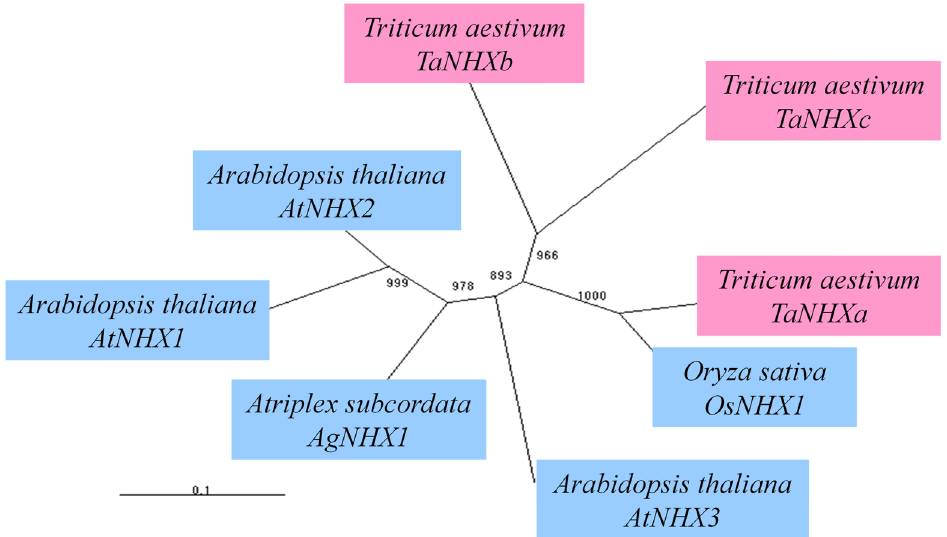
Figure 3 – Evolutionary tree of deduced amino acid sequences of wheat Na + /H + antiporter-like genes. Homogeneity was examined by creating an evolutionary tree of all amino acid sequences of the NHX genes. TaNHXa of bread wheat showed the highest homogeneity with OsNHX1 of rice, while TaNHXb and TaNHXc were hereditarily different from the Na + /H + antiporter genes of the other plants, making them independent. TaNHXa showed the highest homogeneity of 89% with OsNHX1 of rice at the amino acid sequence level, indicating a close relationship. TaNHXa showed 72 % homogeneity with AgNHX1 of Atriplex subcordata and 62 % with AtNHX1 of Arabidopsis thaliana . On the other hand, TaNHXb showed homogeneity of about 60 % with TaNHXa , OsNHX1 , AgNHX1 and AtNHX1 . Moreover, the percentage homogeneity of TaNHXc with TaNHXa and TaNHXb was around 50%, and although the percentage homogeneity with OsNHX1 , AgNHX1 and AtNHX1 was low (46 to 63 %), the 124~149th amino acid residues were similar to AgNHX1 of Atriplex subcordata . It is assumed that of the 3 kinds of Na + /H + antiporter genes in bread wheat, TaNHXa is of the same evolutionary origin as OsNHX1 of Oryza sativa . The two other genes, TaNHXb and TaNHXc , showed low homogeneity with the other plants, possibly contributing to the adaptability of bread wheat to semi-dry areas. Although only 1 kind of Na + /H + antiporter gene was obtained from rice and Atriplex subcordata , 3 were obtained from bread wheat. Since bread wheat is a heteromerous hexaploid with 3 kinds of genome, this suggests that each genome independently has one